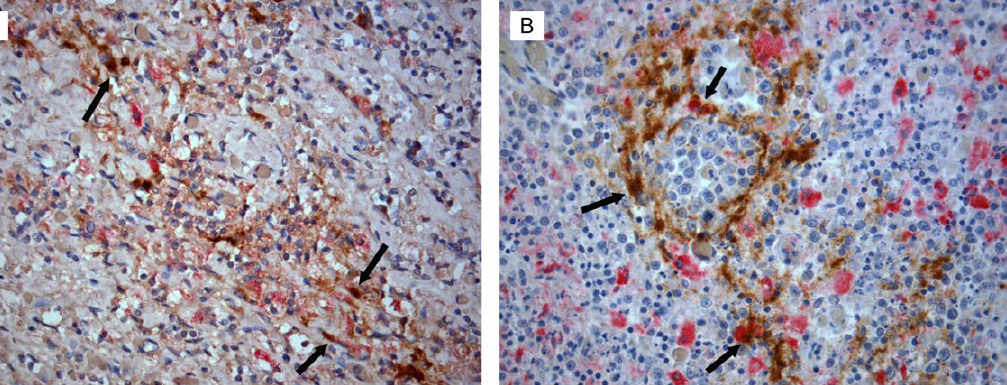
Figure 1. Histopathology of p24 positive macrophages. Tissues from AM and IV were co-stained to identify infiltrating macrophages (CD68, red) and cells productively infected with HIV (p24, brown). Representative tissues of the left axillary lymph node from patient AM (A) and the spleen from patient IV (B) are shown. Examples of double-stained p24 positive macrophages are highlighted by the black arrows. Images are shown at 400X. The distribution and staining pattern similar in all tumor-containing tissues analyzed (not shown). doi:10.1371/journal.pone.0008153.g001 PLoS ONE |